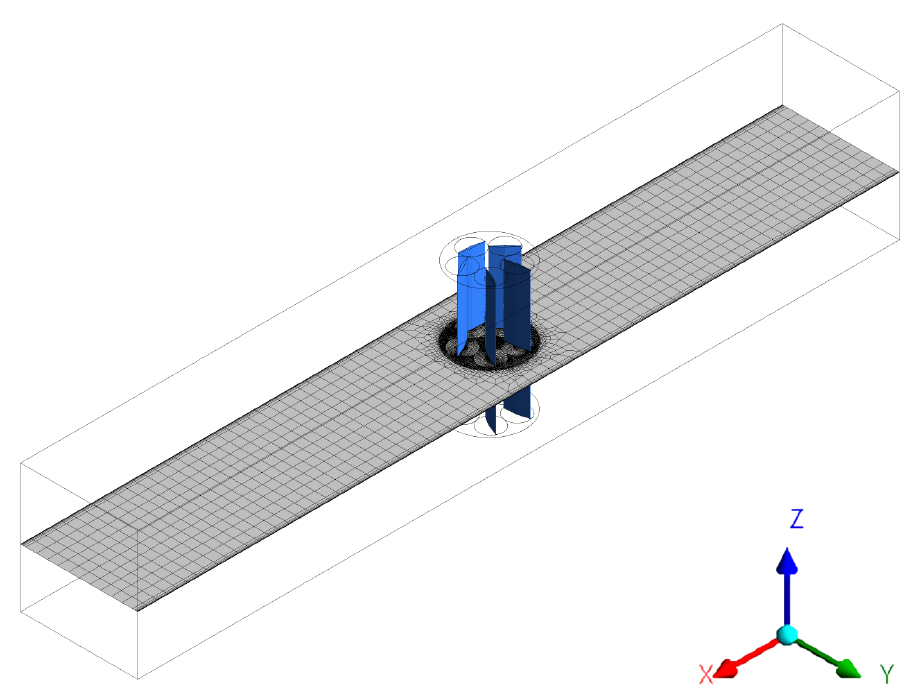
Figure 6. Isometric view of the fluid domain with cross section through the meshing